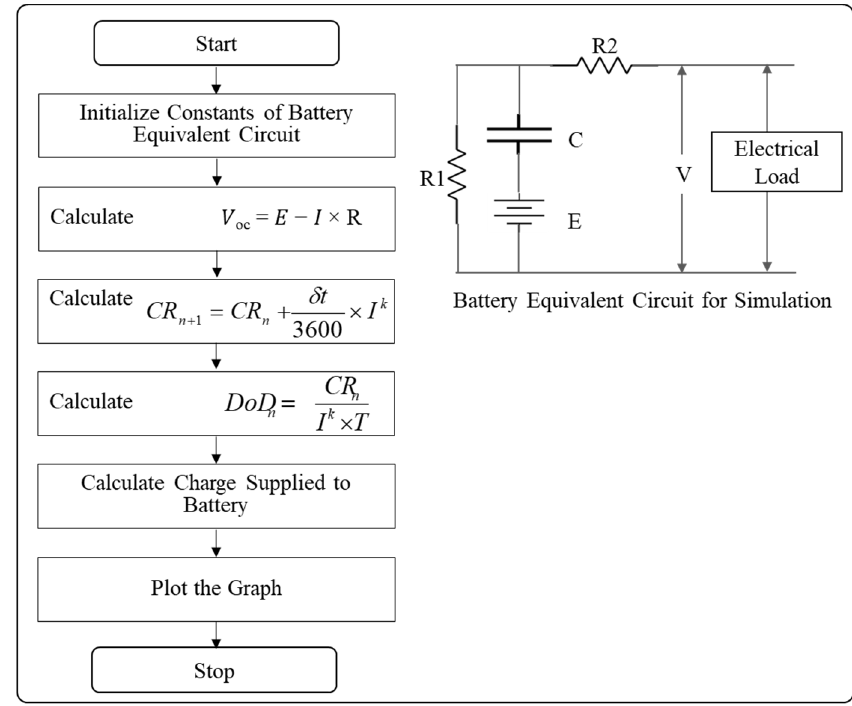
Figure 10. Algorithm for estimating and optimizing battery performance.